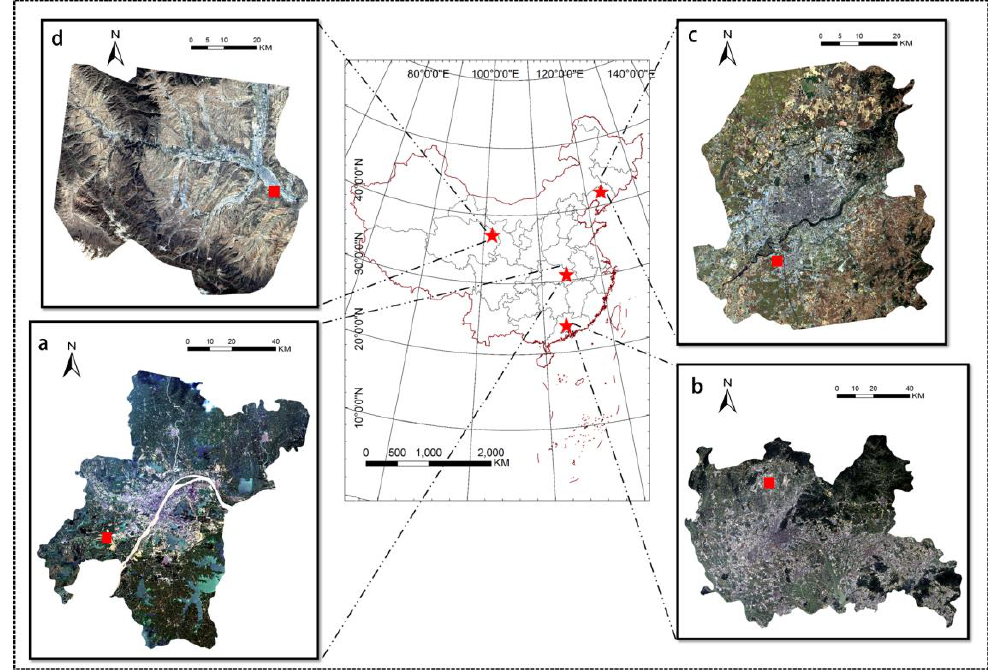
Figure 6. Test areas: ( a ) Wuhan; ( b ) Guangzhou; ( c ) Shenyang; and ( d ) Xining. These cities are illustrated by using true-color composite Landsat 8 images. Remote Sens. 2018 , 10 , x FOR PEER REVIEW